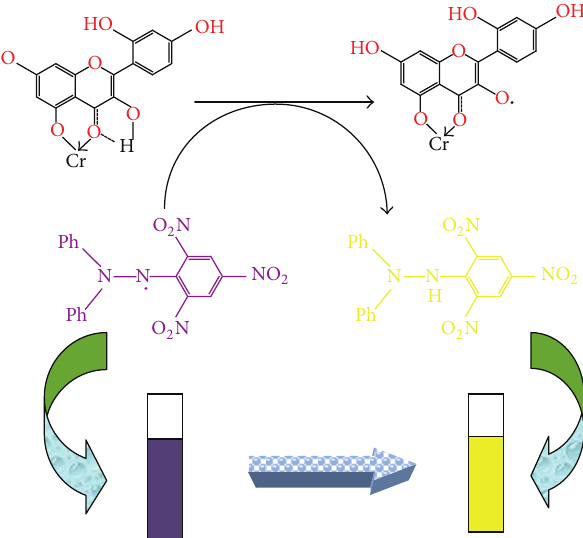
Figure 4: Tentative structure of Cr(III)-morin complex.